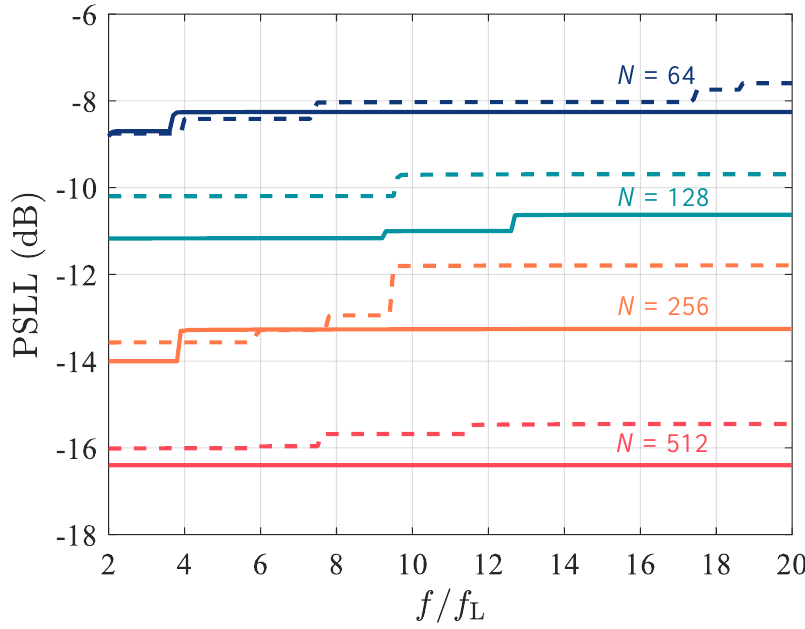
Figure 1. PSLL results of Fermat spiral arrays [15] and parameter − optimized spiral arrays for cases of different numbers of elements. The dotted lines and solid lines represent the results of Fermat spiral arrays and parameter − optimized spiral arrays,